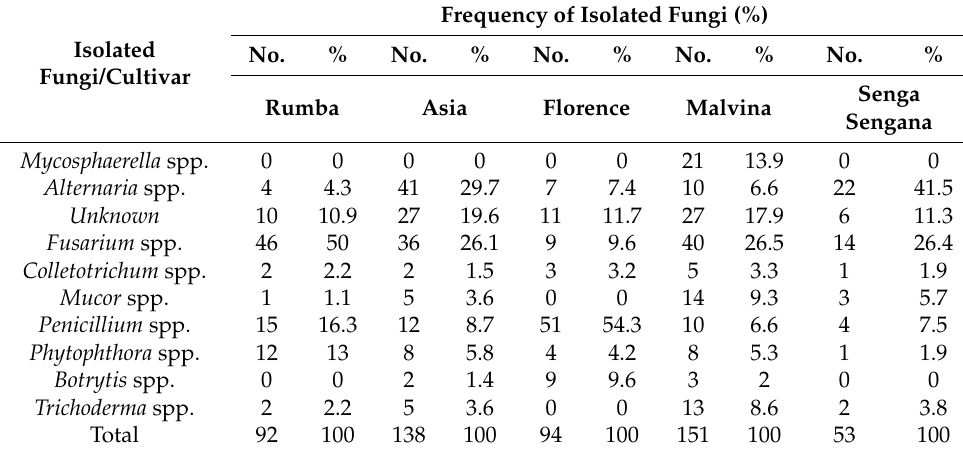
Table 4. Frequency (%) of isolated fungi from the leaves and stems of strawberry plants, 2018–2019. Frequency of Isolated Fungi (%) Isolated Fungi/Cultivar